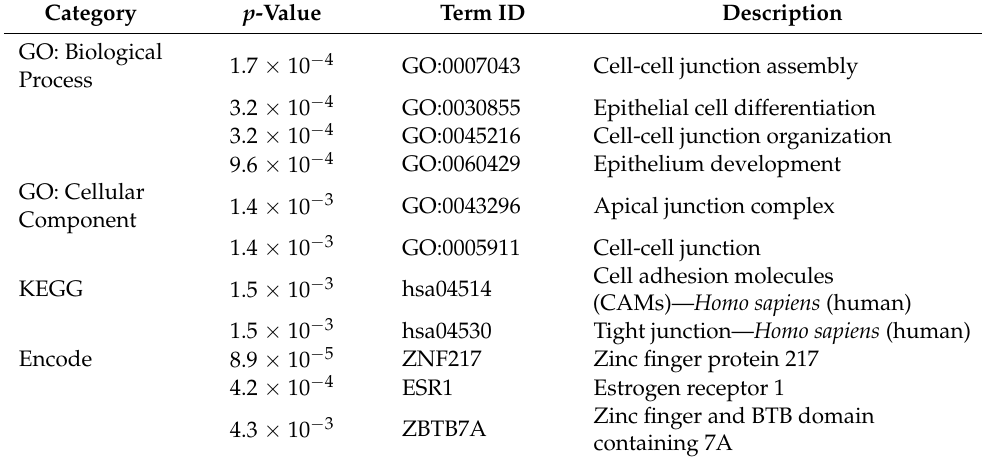
Table 6. Selected top gene term enrichments of the coexpressed genes to TMPRSS2 in